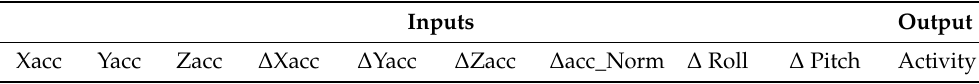
Table 1. ML inputs and output.